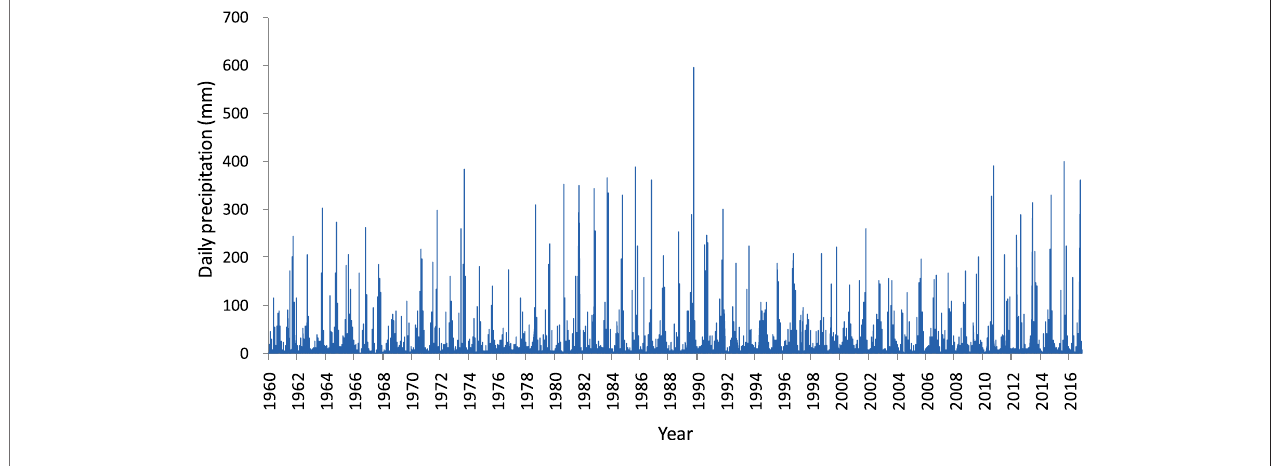
FIGURE 6 | Daily precipitation at Pho Chau during 1960 – 2016.